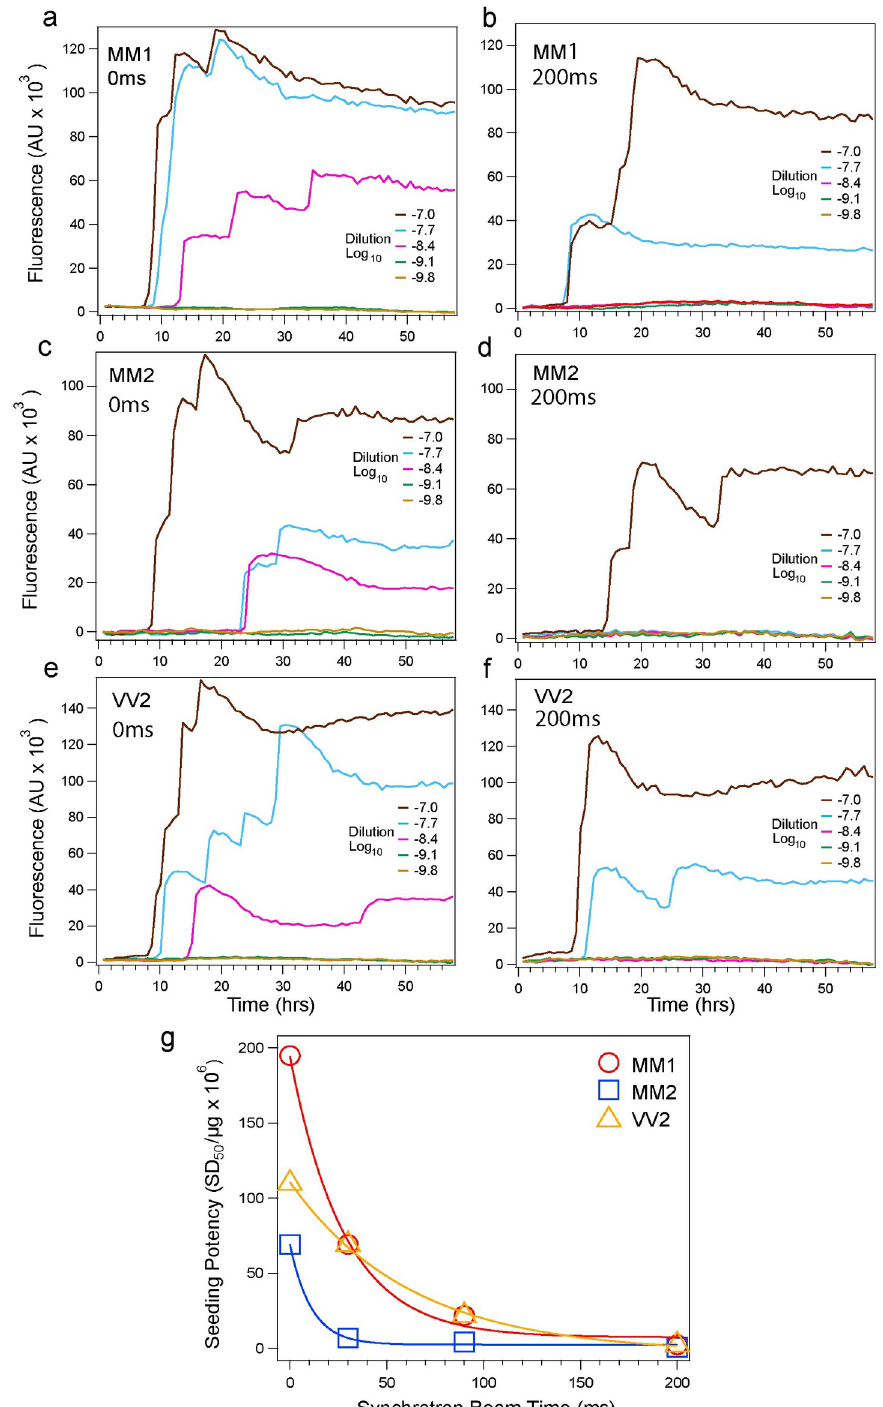
Fig 3. Inactivation rate of human sCJD MM1, MM2, and VV2 sCJD prions by synchrotron •OH. The end-point seeding activity of serially diluted MM1 prions ( a ) before and ( b ) after synchrotron irradiation, end-point seeding activity of serially diluted MM2 prions ( c ) before and ( d ) after irradiation, and seeding activity of serially diluted VV2 prions ( e ) before and ( f ) after synchrotron irradiation. The sCJD prions were irradiated in synchrotron for 0 to 200 ms, serially diluted, and seeding potency of each dilution was monitored by second generation RT-QuIC [41]. The curves in a-f are thioflavin T (ThT) fluorescence averaged at each sample dilution from four wells of 96-well RT QuIC plate as